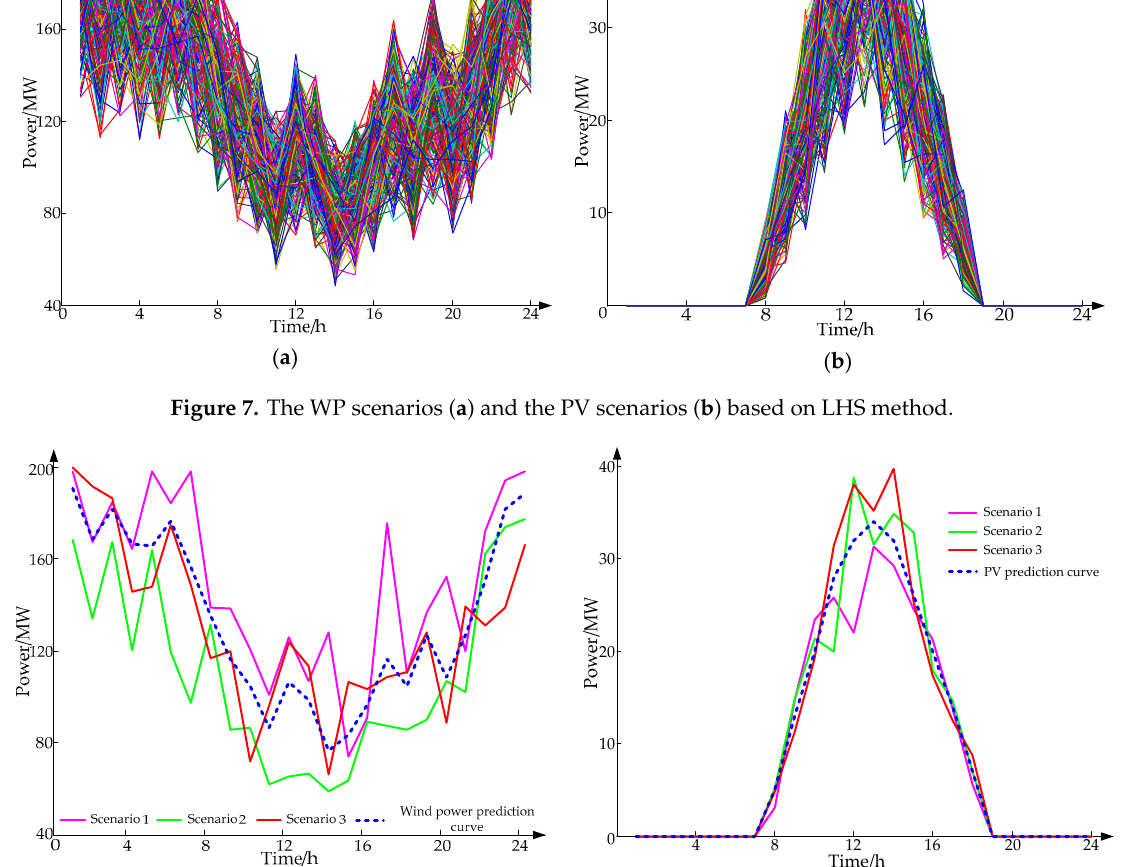
Figure 8. Reduced WP output scenarios ( a ) and PV output scenarios ( b ). Table 1. The probability of the WP scenarios and PV scenarios reduced.